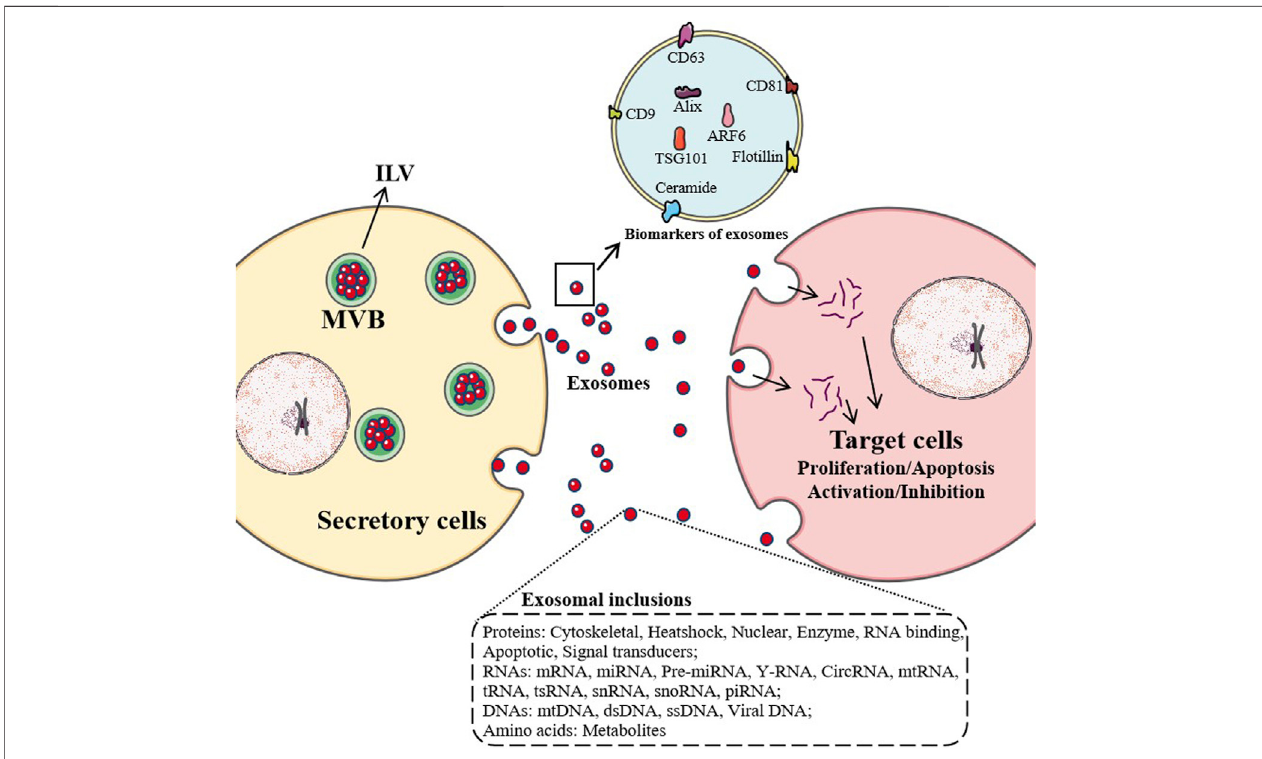
FIGURE 1| Maturation and secretion mechanisms ofexosomes. After most endosomes mature to multivesicular bodies (MVB) or late endosomes, their contents, RNAs,proteins,lipidsarepackagedasintraluminalvesicles(ILV)inMVB.WiththefusionofMVBandcellmembrane,ILVarereleasedasexosomesandentertargetcells by endocytosis, which affect the physiological and pathological mechanisms of target cells, such as proliferation, apoptosis, activation and inhibition.